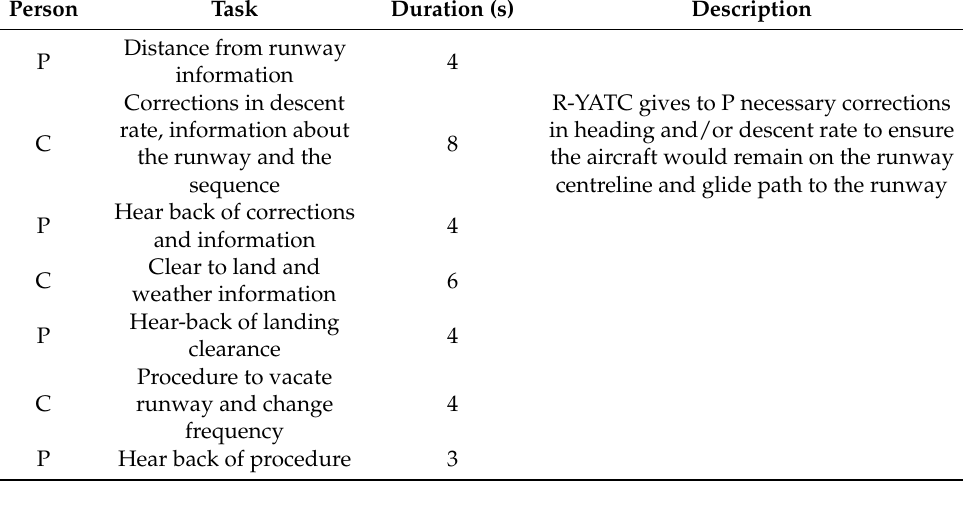
Table 6. Arrival tasks of R-YATC.